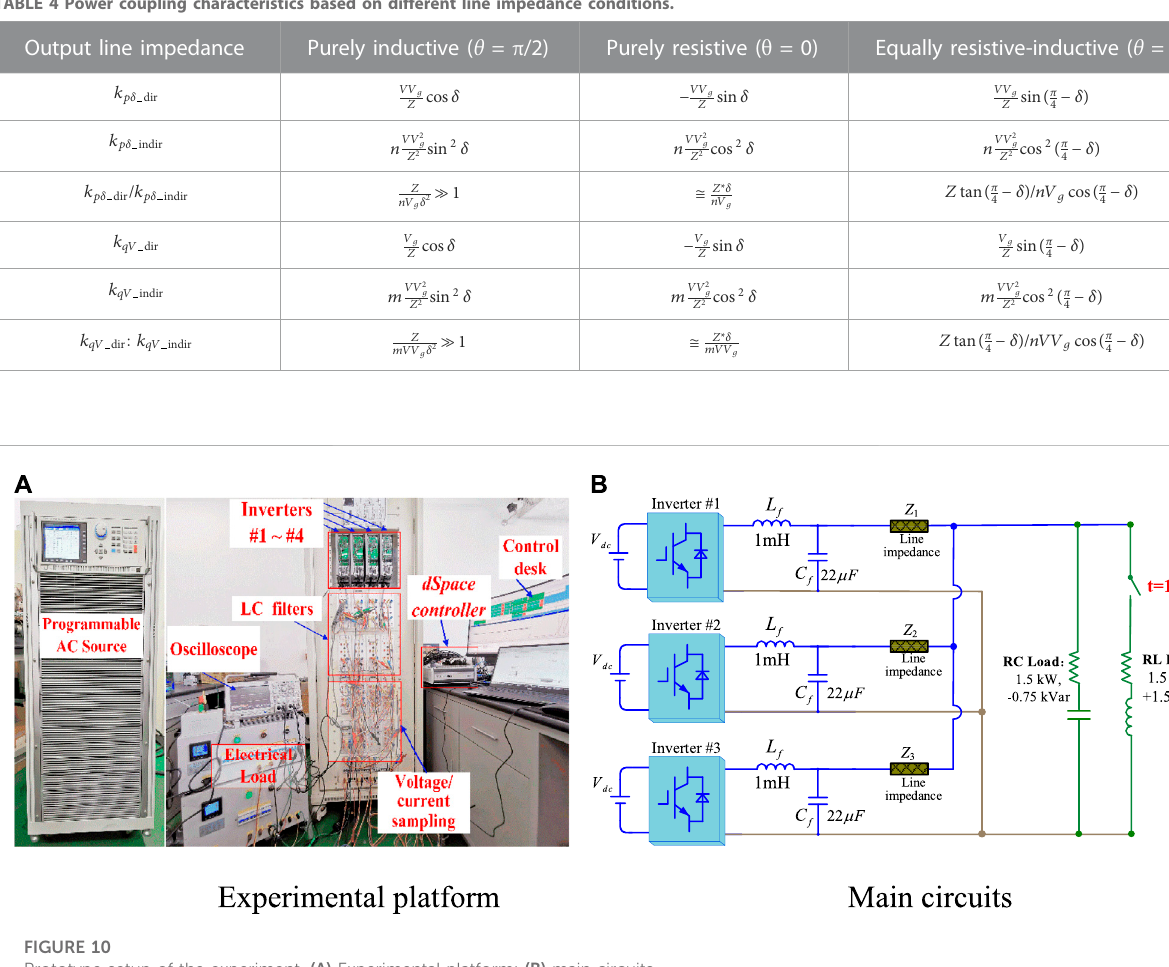
FIGURE 11 United Control Scheme of the three-inverter parallel